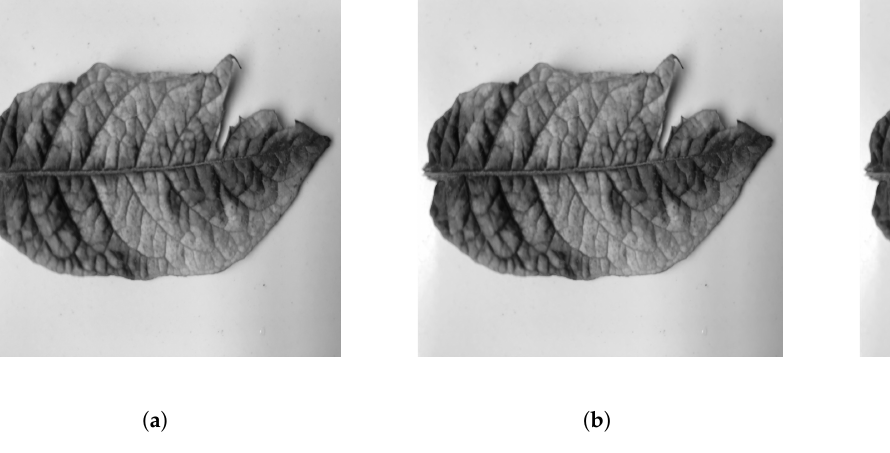
Figure 10. ( a ) original image, ( b ) reconstructed image with a percentage of 90% sparsity with a PSNR of 30.02 dB, and ( c ) reconstructed image with a percentage of 95% sparsity with a PSNR of 26.81